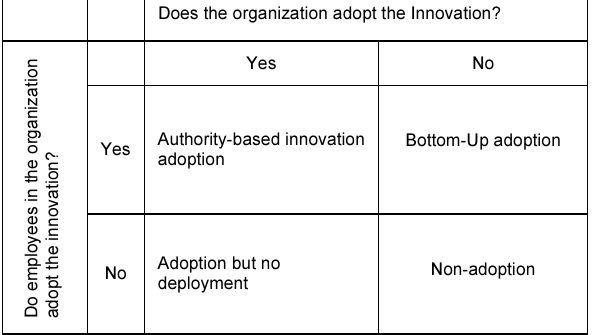
Fig. 5. Combinations of individual and organizational decisions for adoption (Gallivan 2001)